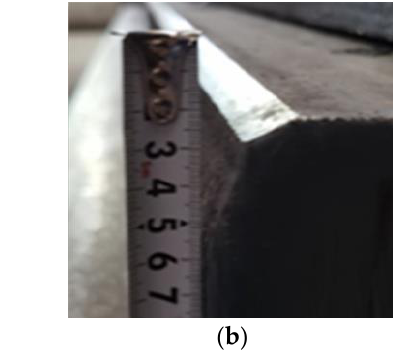
Figure 17. A two-chamfered shape slab. ( a ) Hot slab; ( b ) cold slab.